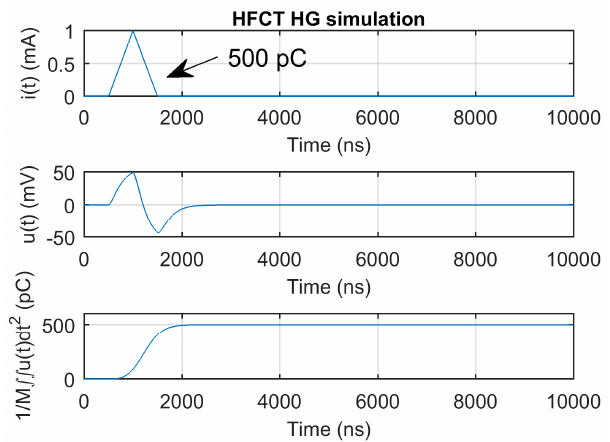
Figure 10. HFCT_HG sensor response and charge estimation of a 500 pC and 1000 ns triangular current pulse.